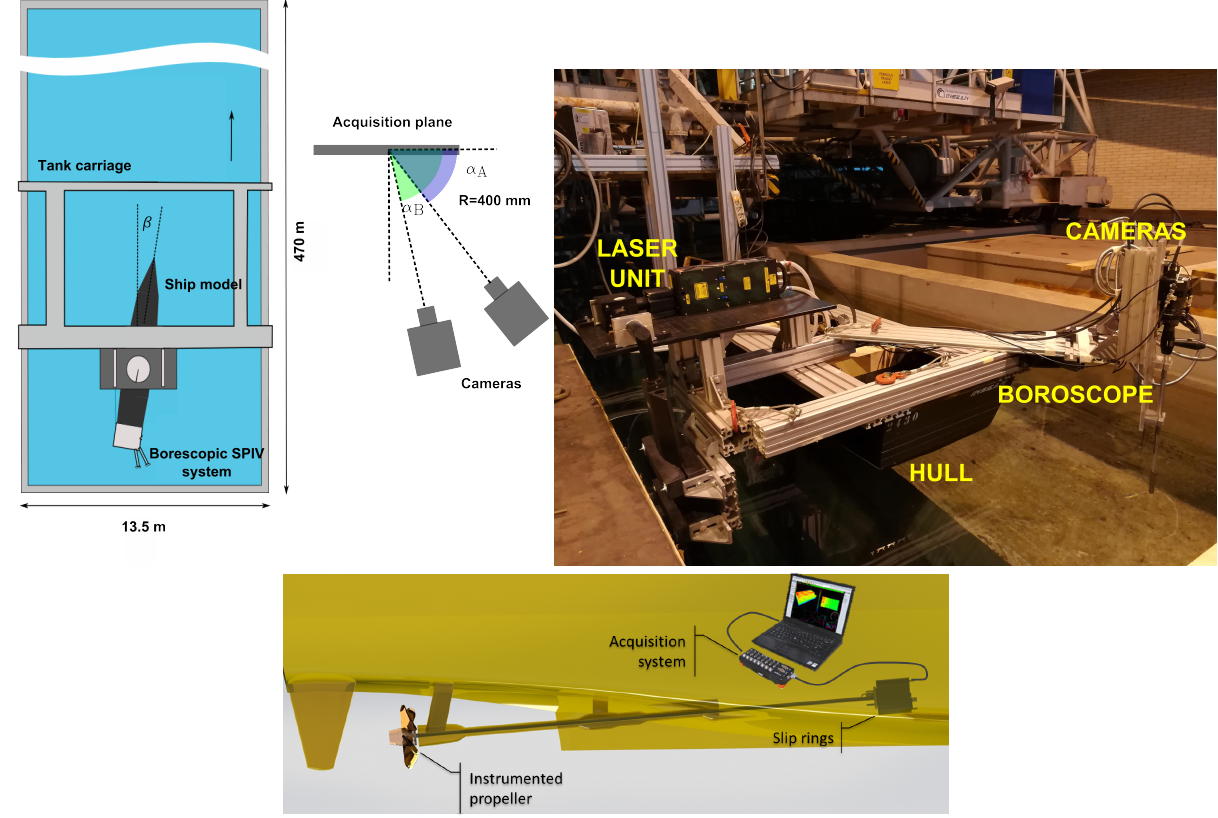
Figure 2. Model hull. ( Top and center ) towing tank and borescopic SPIV set-up. ( Bottom ) Multi-axial loads